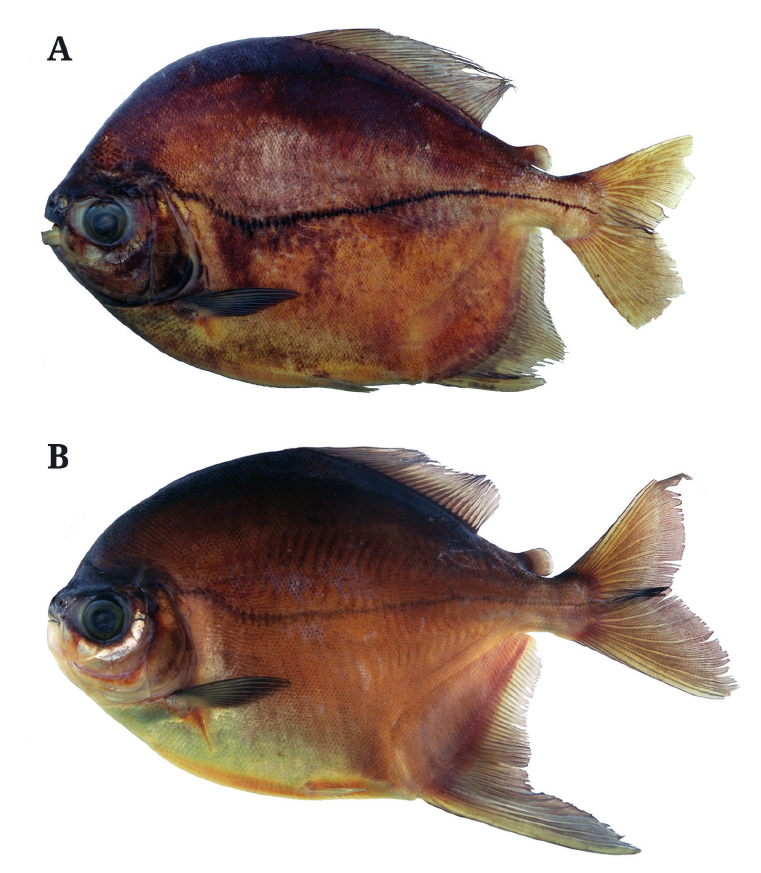
FIGURE 3 | Myloplus nigrolineatus , paratypes, INPA 23312, lago Mabi, São Gabriel da Cachoeira, Amazonas State, Brazil. A. 199.1 mm SL, male; B. 182.0 mm SL,